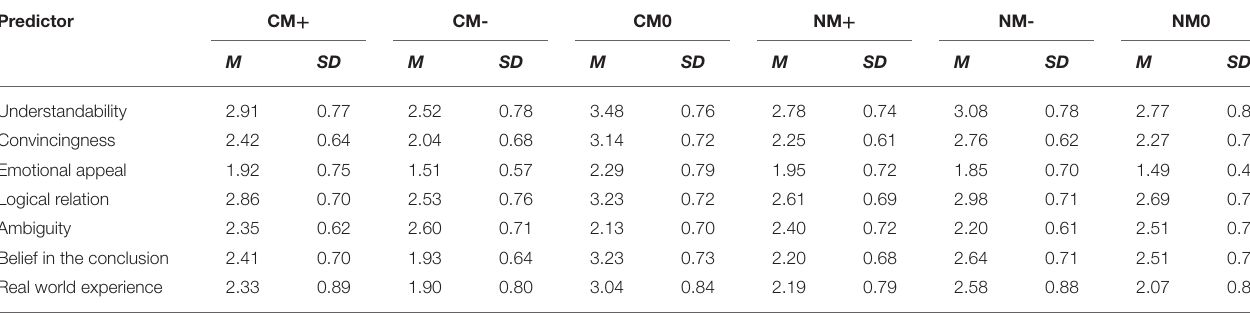
TABLE 10 | Mean (M) and standard deviation (SD) values of each predictor for each middle term condition (Experiment 2). Predictor